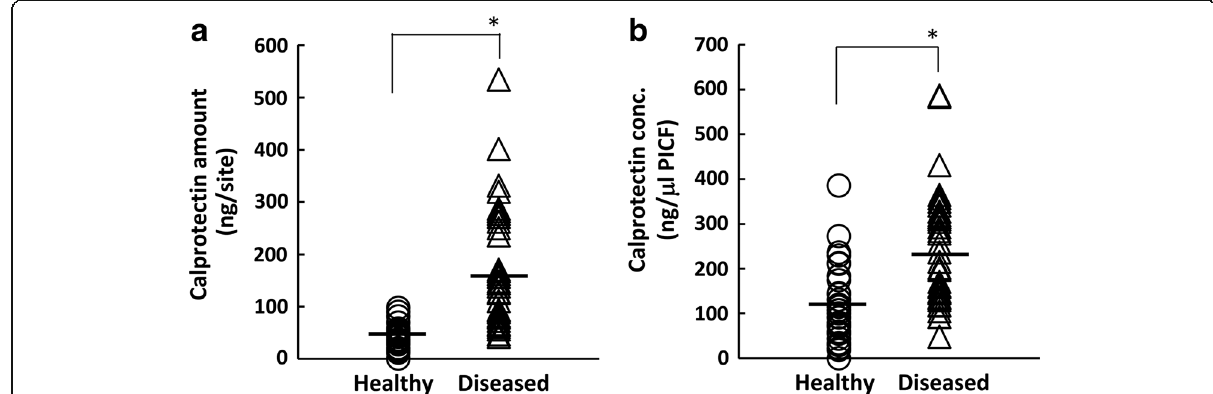
Fig. 1 Comparison of calprotectin levels in PICF. PICF samples were collected from peri-implant disease sites ( n = 40, diseased) and non-diseased sites ( n = 34, healthy). Calprotectin amounts ( a ) were measured by ELISA, and its concentration ( b ) was normalized by the volume of PICF. Horizontal bars show the mean values of each group. * P < 0.01